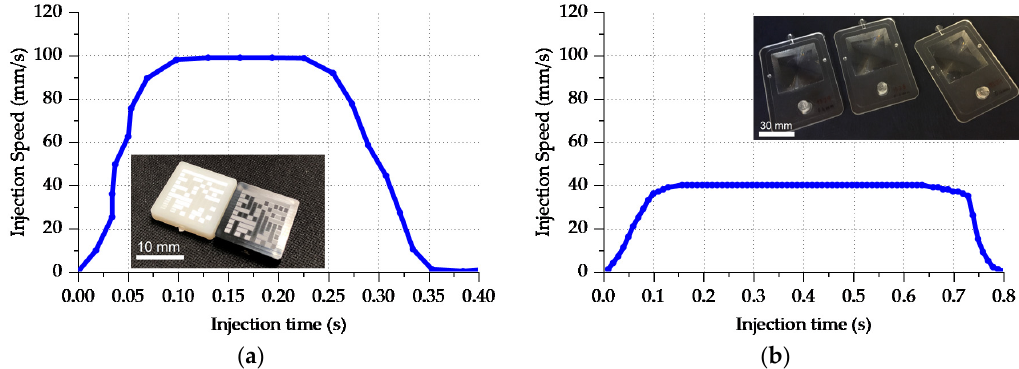
Figure 15. Injection speed profiles sampled from the machine controller for Cases 3 ( a ) and 4 ( b ).